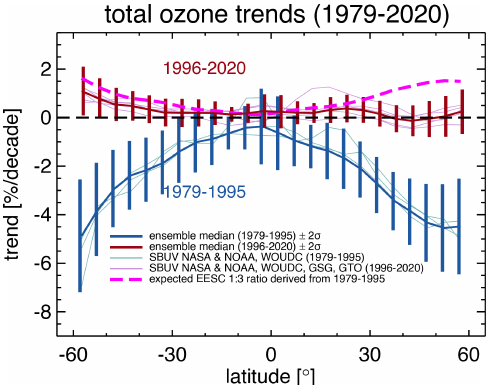
Figure 4. Same as Fig. 3 but from applying the standard MLR (Eq. 1 and P ( t ) = 0)).